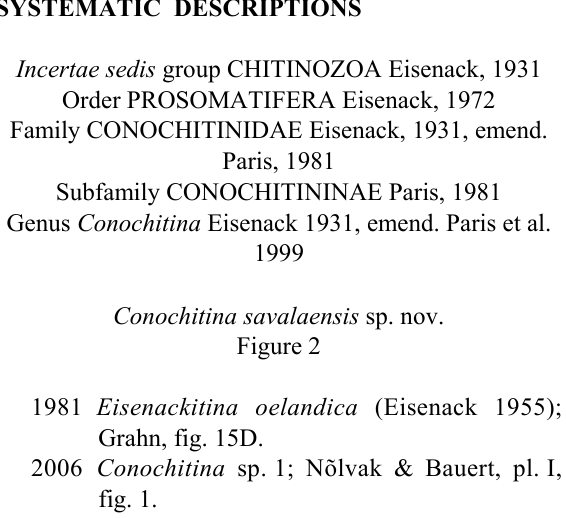
Derivation of name . The species name refers to the locality name Savala (a settlement in NE Estonia), which is the site of the Savala drill core. Holotype . GIT 660-1666; Fig. 2A; Viljandi drill core, 373.8 m, Kukruse Regional Stage (RS). Type locality and horizon . Viljandi drill core, 373.3– 374.3 m, the Kiviõli Member of the Viivikonna Formation, lower part of the Kukruse RS, lowermost